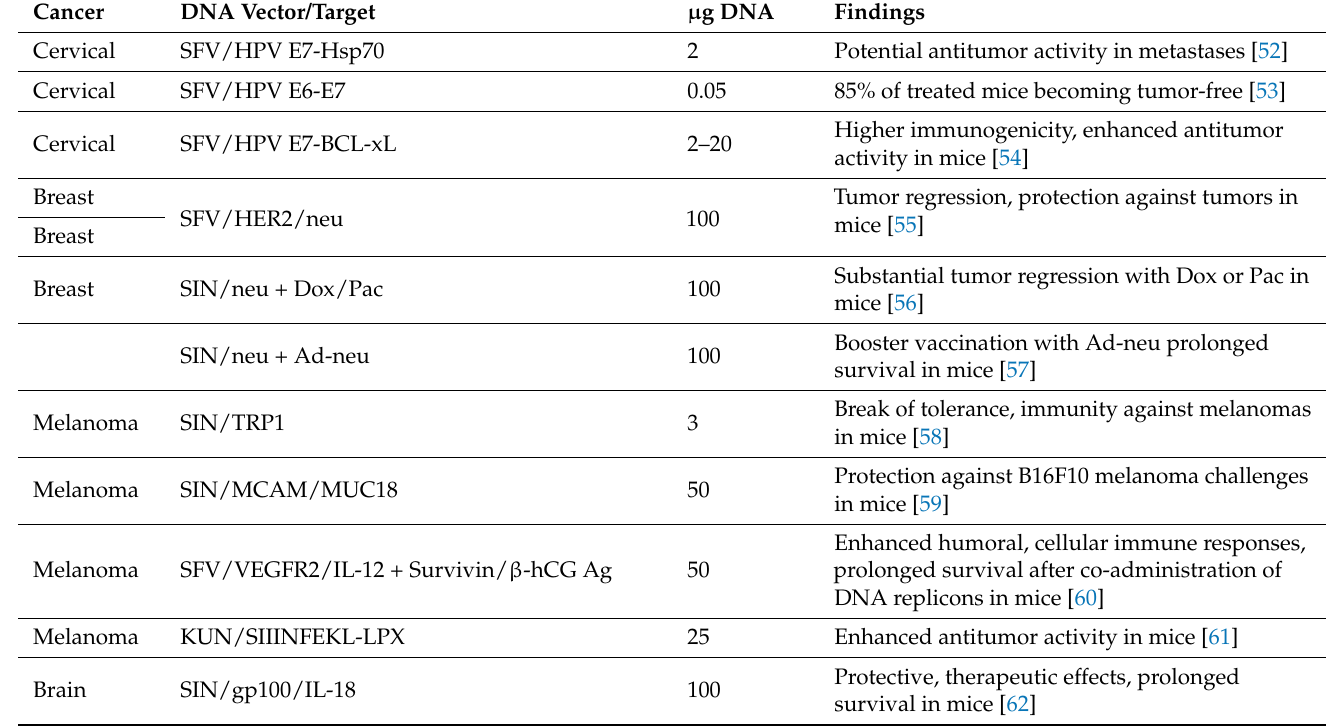
Table 2. Examples of DNA replicon-based cancer therapy and